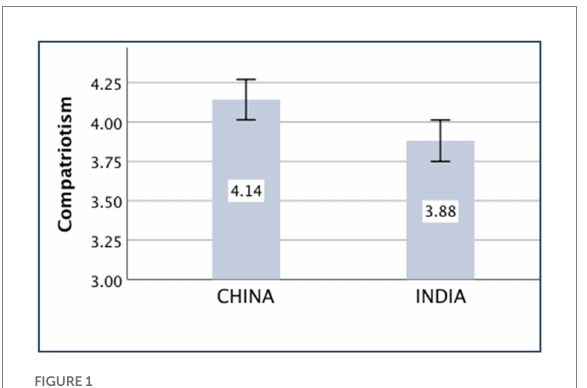
FIGURE 1 Compatriotism of China and India.